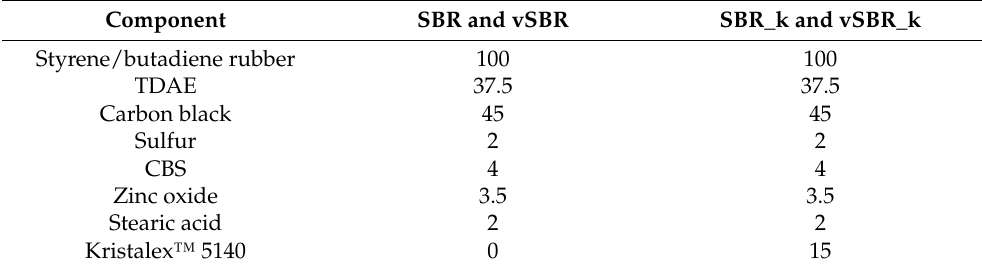
Table 1. Sample composition in phr (parts per hundred rubber).